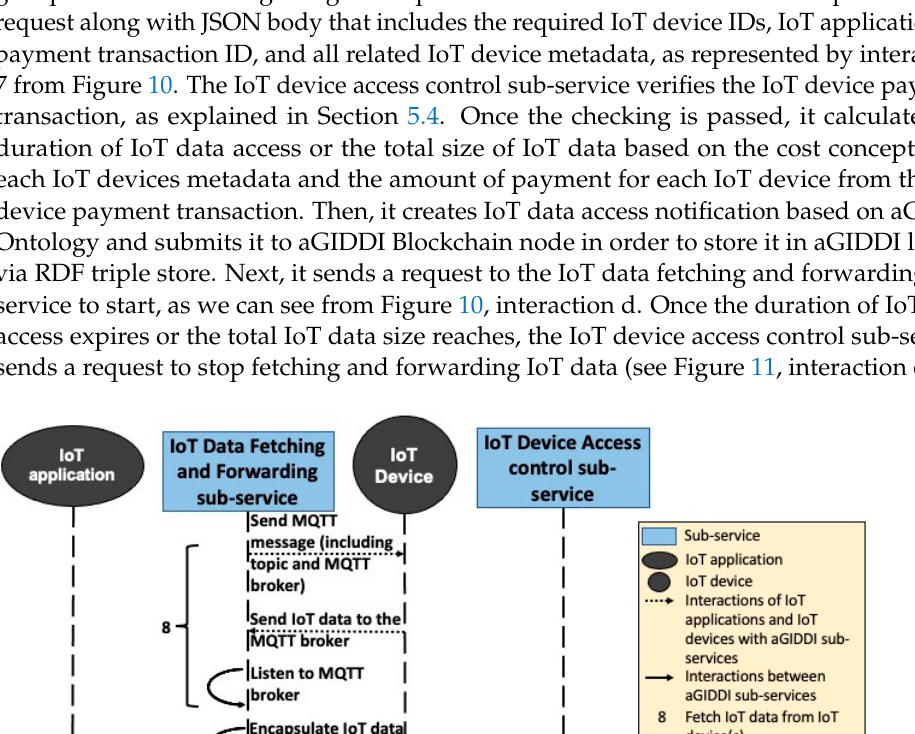
Figure 10. aGIDDI protocol for IoT device integration (controlling the access of IoT devices).